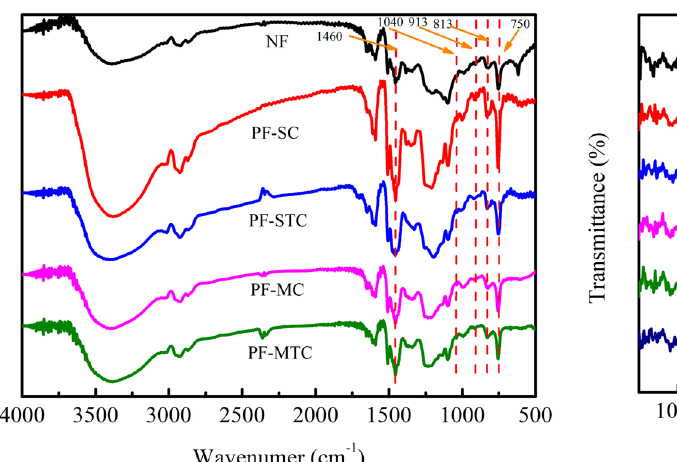
Figure 3: Infrared spectra and the corresponding analysis point lattice for microscopic infrared imaging.